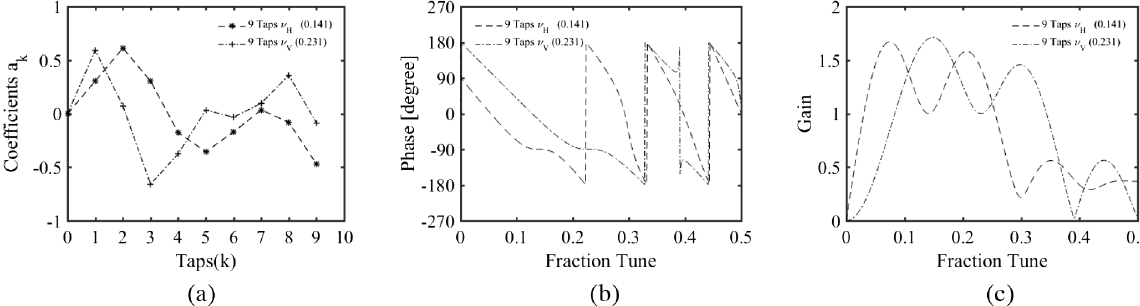
FIG. 10. FIR filter coefficients (a), frequency response of phase (b), and gain (amplitude) (c) of the nine-tap filters used in a bunch-by- bunch feedback system. The horizontal and vertical target tune fractions are 0.141 and 0.231, respectively.